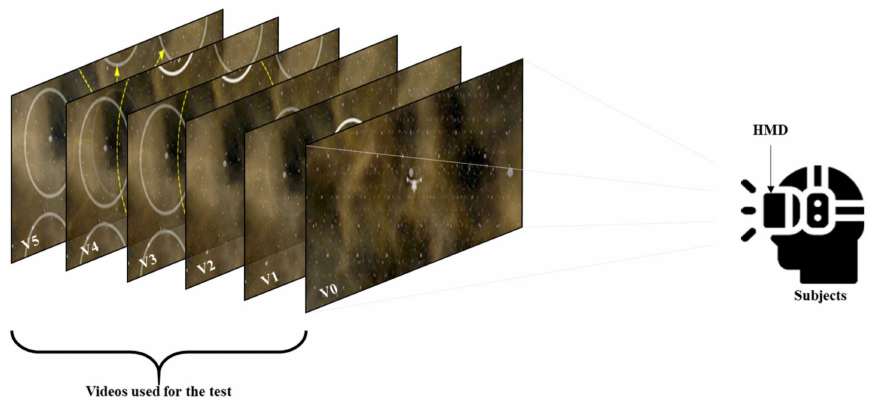
Figure 6. Experimental environment. Table 1. VR sickness reduction method used in the experiment.